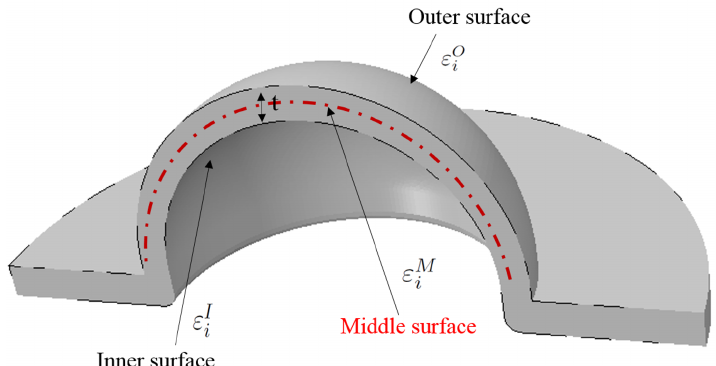
), Inner surface ( (cid:101) I ) and i i